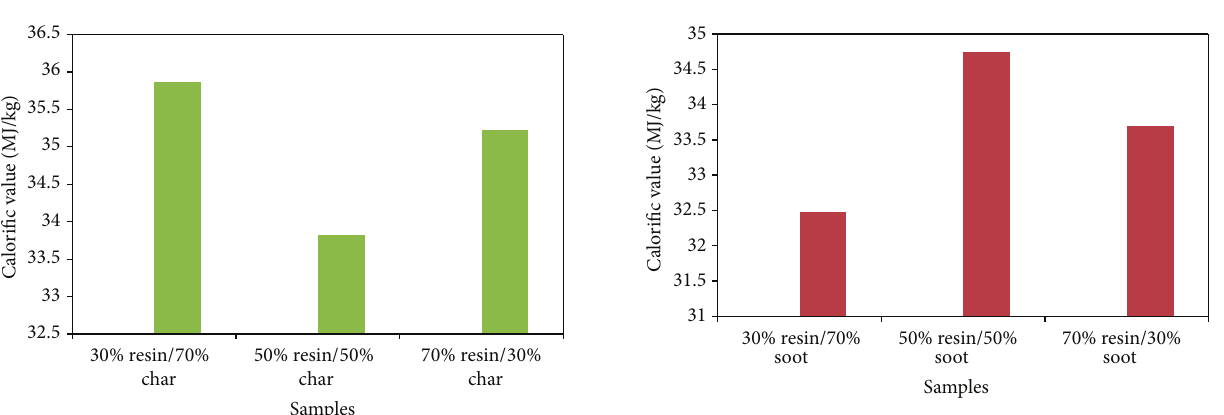
Figure 3: The calorific values of blended samples of resin and